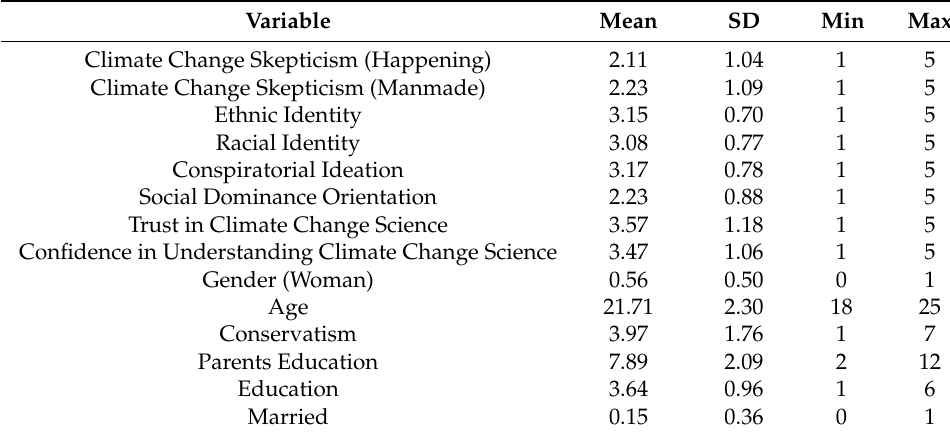
Table 1. Descriptive Statistics of Study